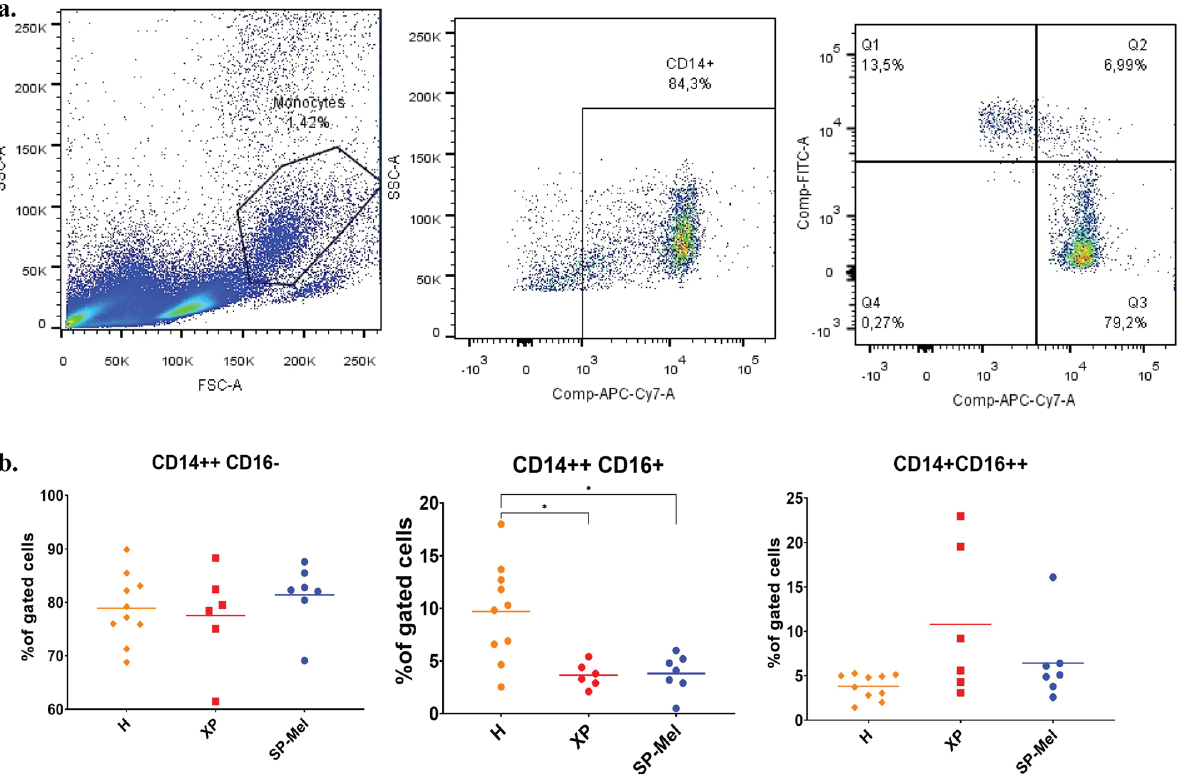
Figure 5. Characterization of blood monocyte’s subsets in healthy donors (n = 18), in patients with sporadic melanoma SP-Mel (n = 8), and in Xeroderma Pigmentosum patients (n = 6) ( a ) Gating strategy for the identification of the three monocyte’s subsets ( b ) Percentages of the different monocyte’s subsets CD14 + + CD16- classical CD14 + CD16 + intermediate and CS14 + CD16 + + non classical (* p -value <